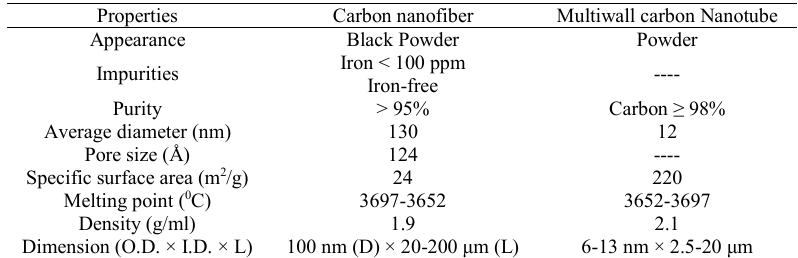
Table 2. Properties of nanomaterials used for this paper (presented by their produced company).